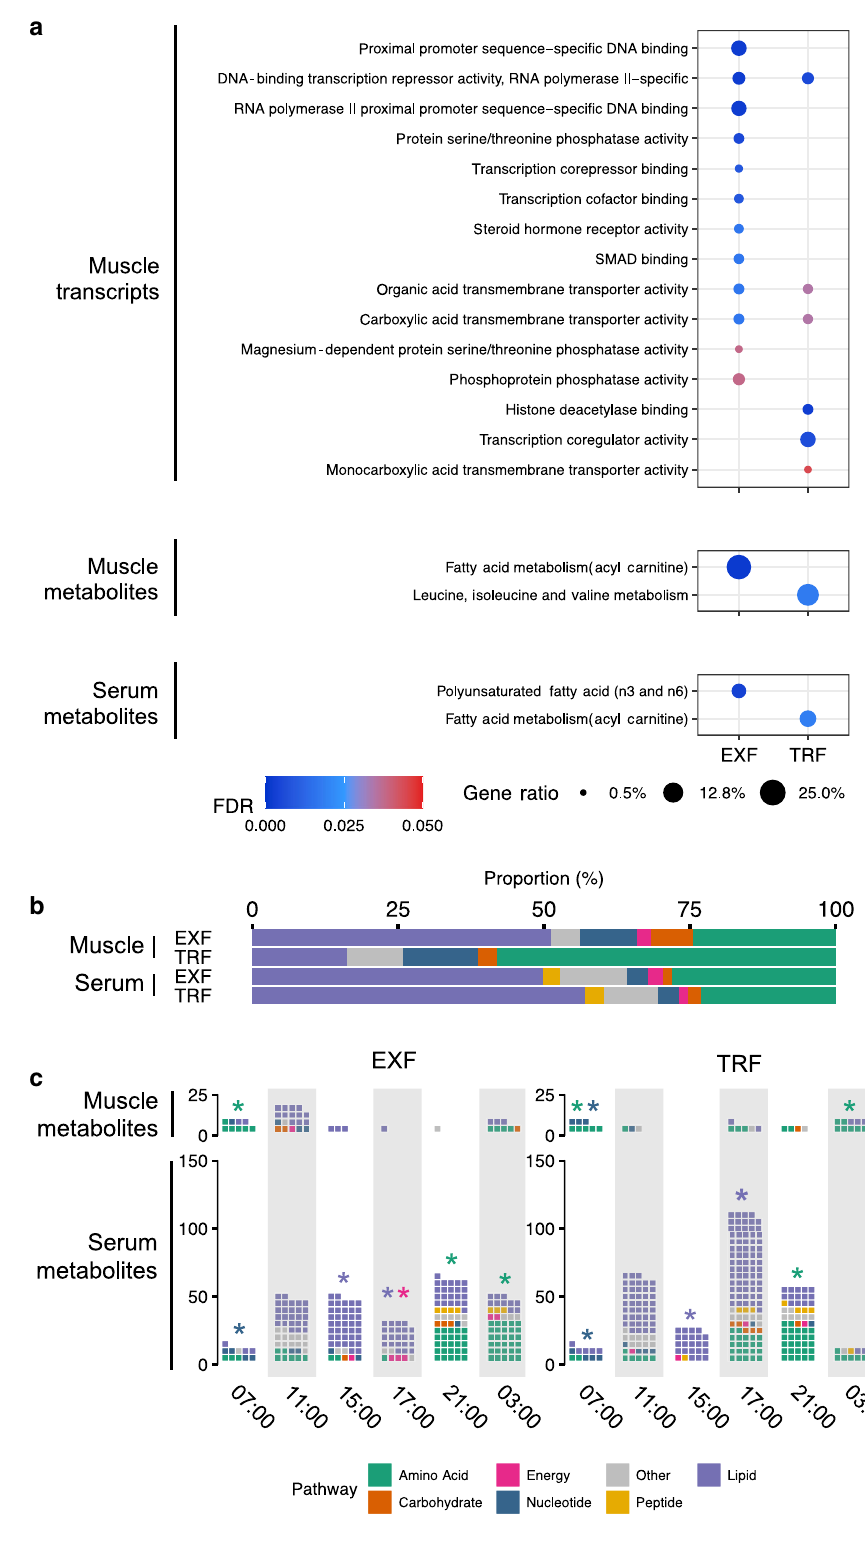
Fig. 6 Functional enrichment of periodic features. Over-representation analysis of molecular function gene ontology in skeletal muscle periodic transcripts (top panel), and Metabolon sub-pathway de fi nition of skeletal muscle metabolites (middle panel), and serum metabolites (bottom panel) after unrestricted feeding (EXF) and time-restricted feeding (TRF). Color indicates FDR adjusted p value; circle size indicates the proportion of periodic genes in the ontology ( a ). Proportion of Metabolon super-pathway de fi nition of periodic metabolites in skeletal muscle and serum after EXF and TRF ( b ). Counts of super- pathway de fi nition of periodic metabolites in skeletal muscle and serum after EXF and TRF at each measured timepoint. Color indicates metabolite classi fi cation ( c ). * p < 0.05, n = 11